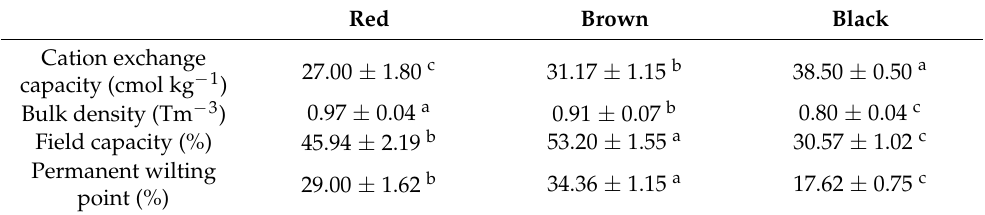
Table 2. Analysis of the three soils (red, brown, and black) used to produce Habanero peppers ( Capsicum chinense